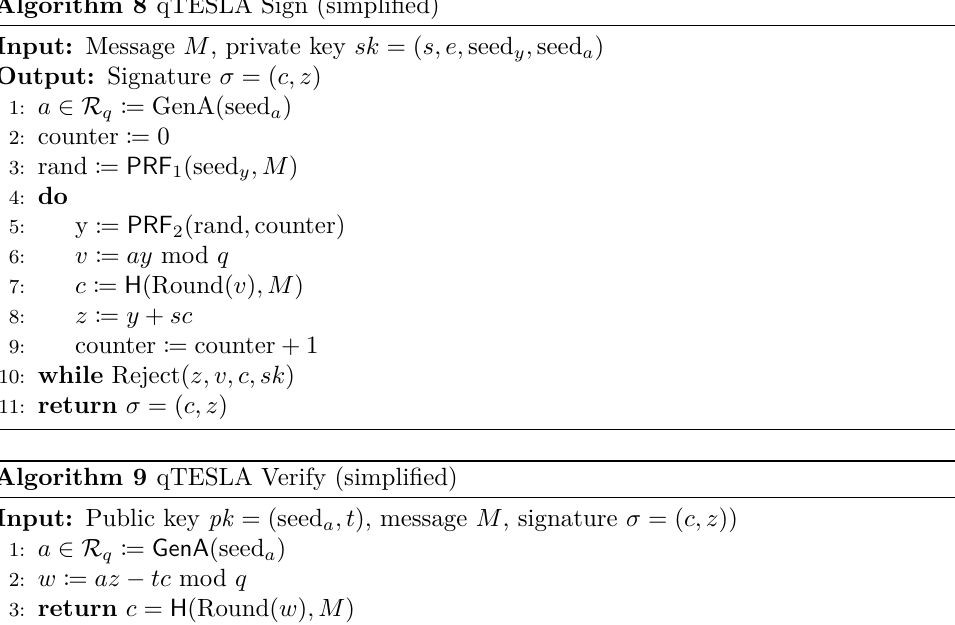
Algorithm 8 qTESLA Sign (simplified)